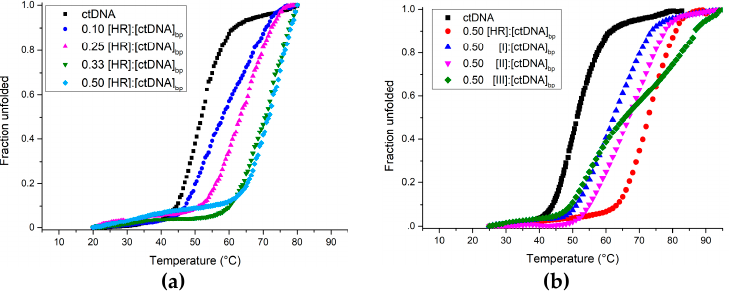
Figure 2. Normalised UV-Vis thermal melting profiles of Calf thymus DNA (ctDNA) at increasing [HR]:[ctDNA] bp ratio ( a ); and at [ligand]:[ctDNA] bp of 0.50 ( b ). The ligand concentrations were increased over a fixed (ctDNA) bp . Melting curves were obtained monitoring the absorbance at 260 nm as a function of temperature.